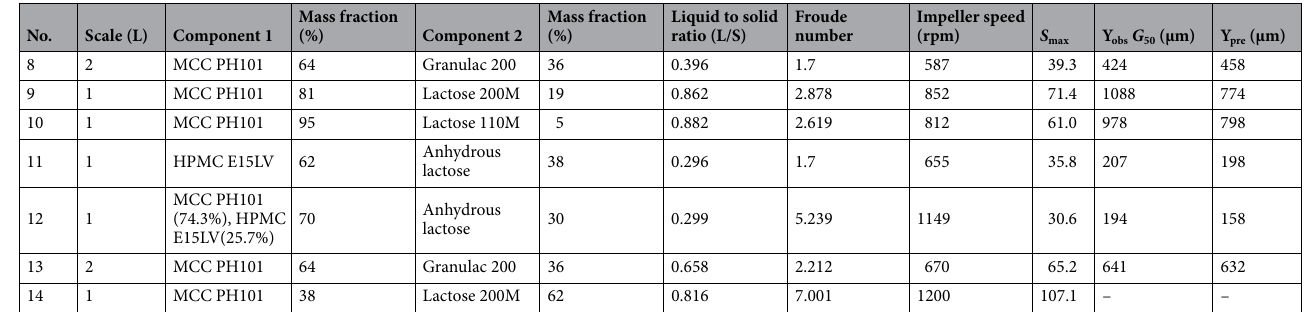
Table 3. The results of external validation